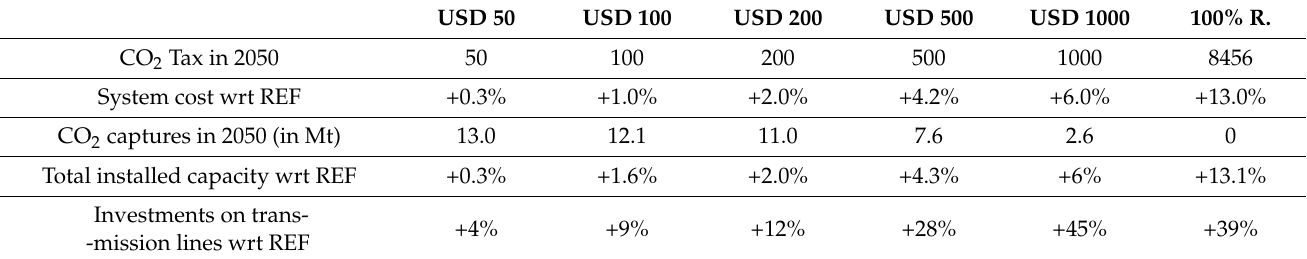
Table 5. Detailed results for the net-zero emissions scenarios with CCS activity.